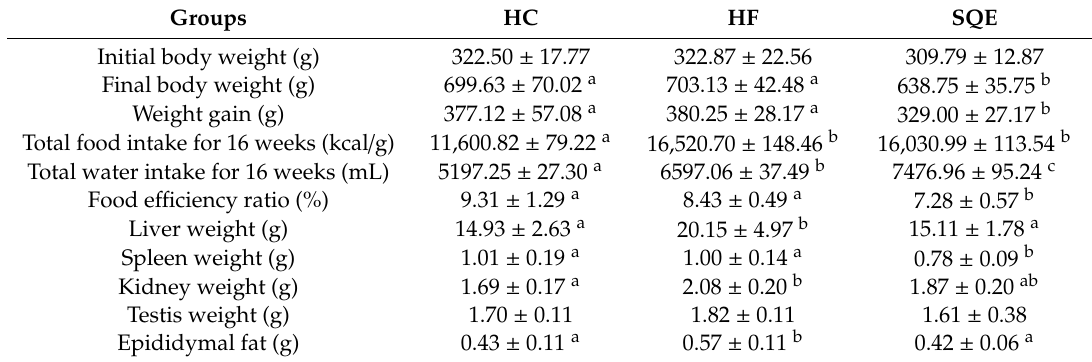
Table 1. E ff ect of Sasa quelpaertensis leaf extract (SQE) supplementation on body weight, food